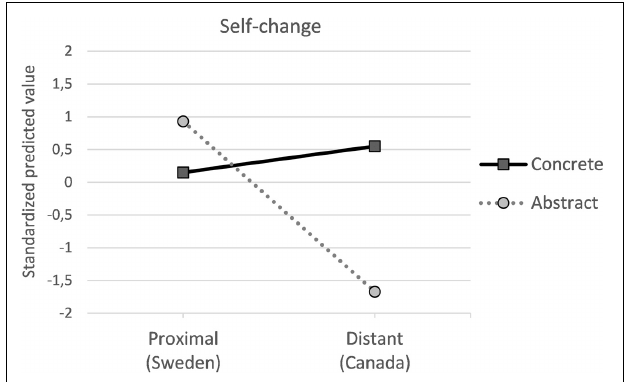
FIGURE 3 | Standardized predicted mean values for willingness to self-change.